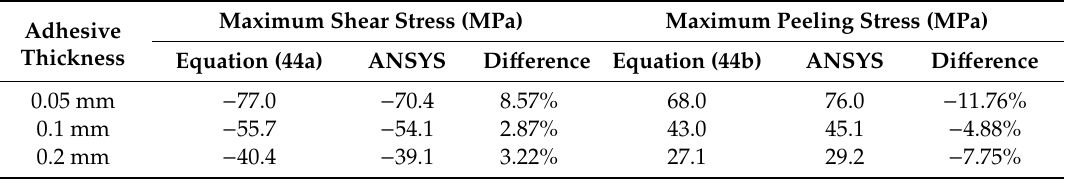
Table 3. Comparison of maximum interfacial stresses with di ff erent adhesive thicknesses obtained by Equation (44) and